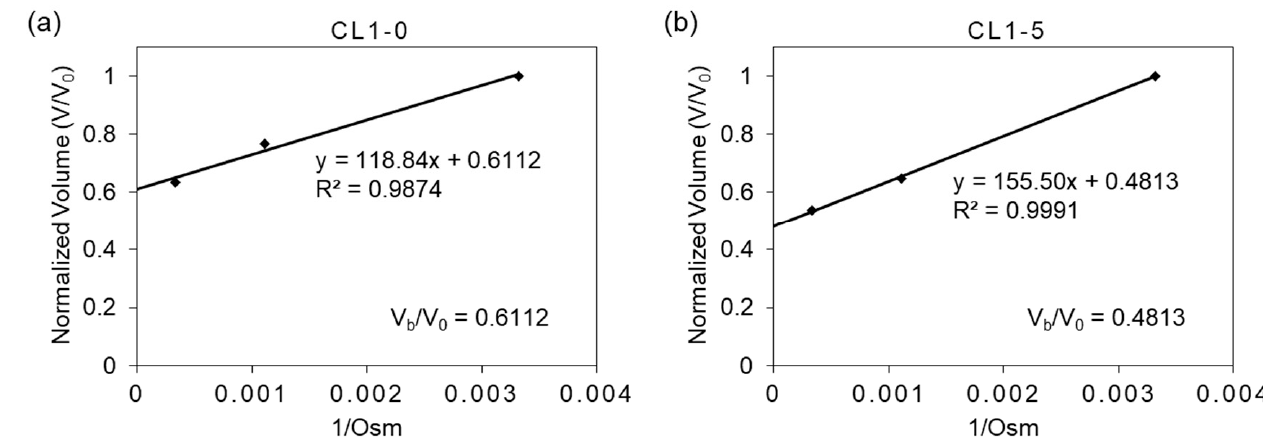
Figure 2. The Boyle–van’t Hoff relationship of ( a ) CL1-0 and ( b ) CL1-5. The equilibrium cell volumes in isotonic (1 × PBS) and hypertonic (3 × and 10 × PBS) saline solutions, normalized to the cell volume in isotonic solution are plotted against the reciprocal of the osmolality of the solution.